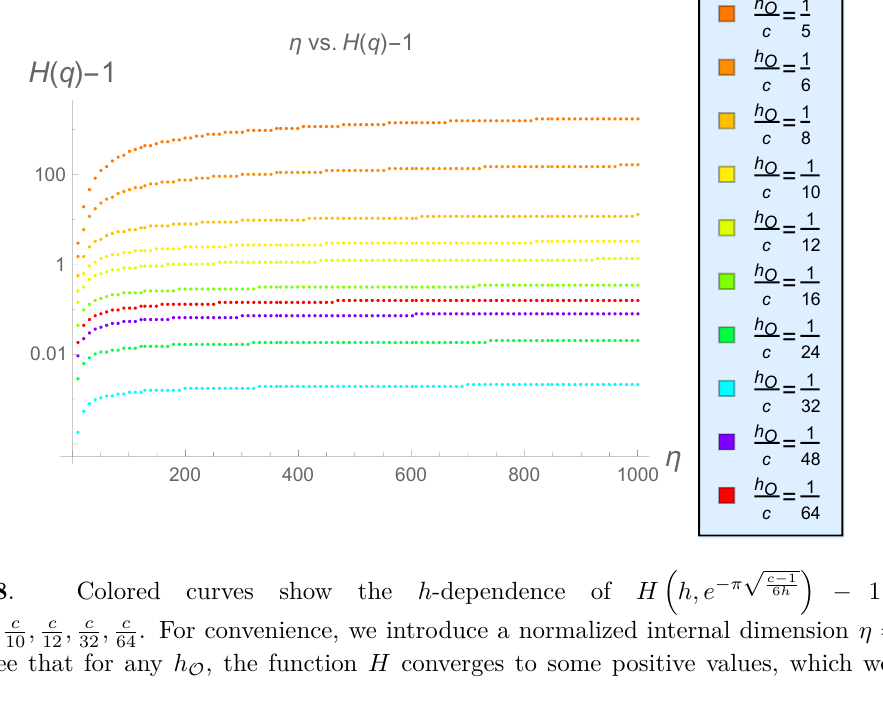
√ (cid:16) (cid:17) c − 1 h, e − π − 1 with 6 h h . c